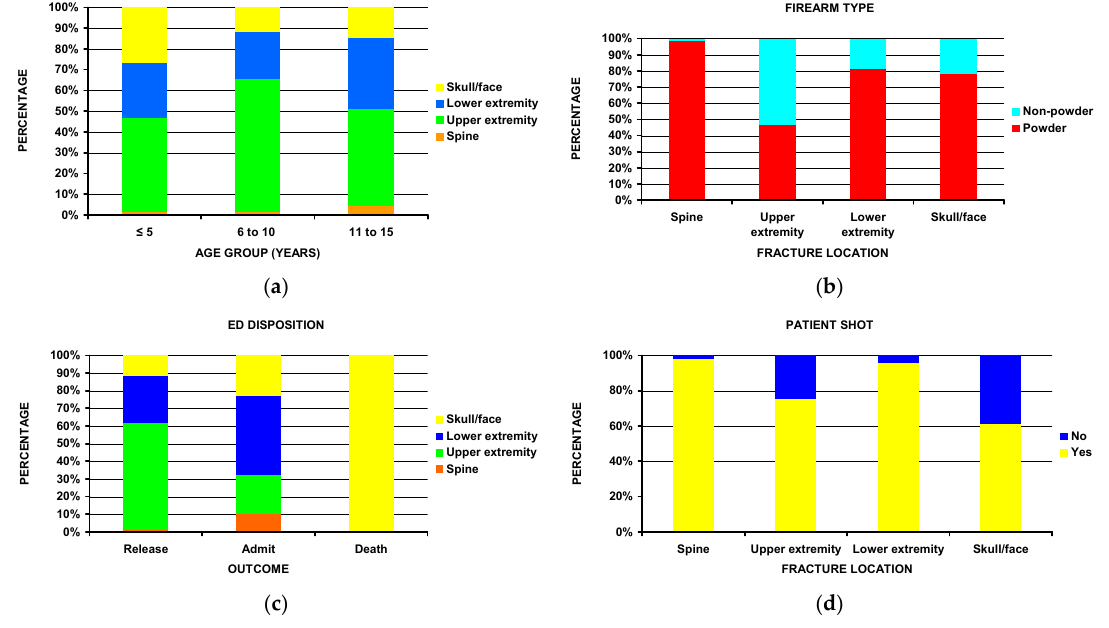
Figure 2. Differences between the four major fracture locations (spine, upper extremity, lower extremity, and skull/face: ( a ) by age group ( p = 0.041); ( b ) by firearm type ( p < 10 − 4 ); ( c ) by ED disposition ( p = 0.0001); ( d ) by being shot or not ( p < 10 − 4